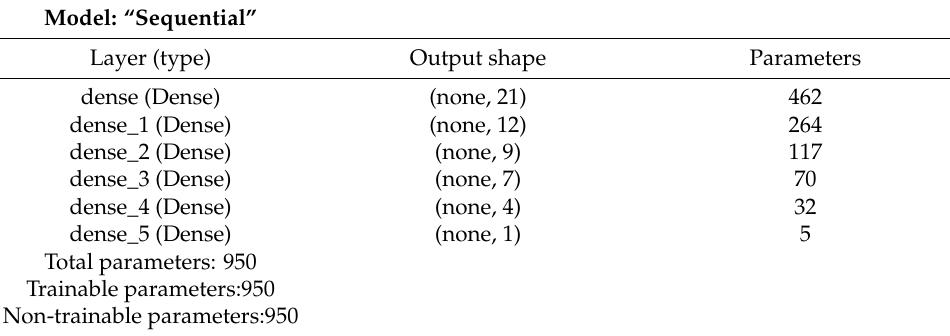
Table 5. Architecture of the custom DNN classifier utilized in this